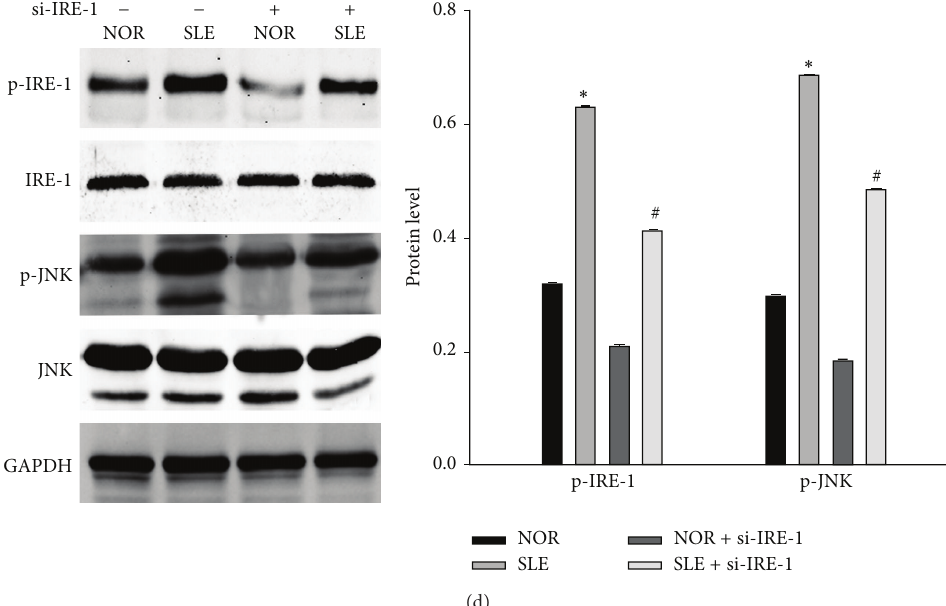
Figure 5: The role of MAPK on ERS-induced apoptosis of BM-MSCs from SLE patients. (a) BM-MSCs of SLE patients and normal controls were treated with (+) or without ( − ) 4-PBA (100 𝜇 M) from the same time point for the indicated time. The levels of p-ERK1/2, total ERK1/2, p-JNK1/2, total JNK1/2, p-p38, and total p38 were detected by western blotting respectively. (b) Immunofluorescence analysis of p-JNK1/2 expression in the control group and SLE group treated with or without 4-PBA. (c) BM-MSCs of SLE patients and normal controls were transfected with scramble ( # ) or 20 nM JNK1/2 siRNA for 48 h using the RNAifect transfection reagent. Western blot analysis was performed for p-JNK1/2 and BAX. (d) BM-MSCs of SLE patients and normal controls were transfected with scramble ( # ) or 50 nM IRE-1siRNA for 48 h using the RNAifect transfection reagent. Western blot analysis was performed for p-JNK1/2 and p-IRE-1. (Bar represents mean ± SD, ∗ 𝑃 < 0.05 compared with the normal group, # 𝑃 < 0.05 compared with the SLE